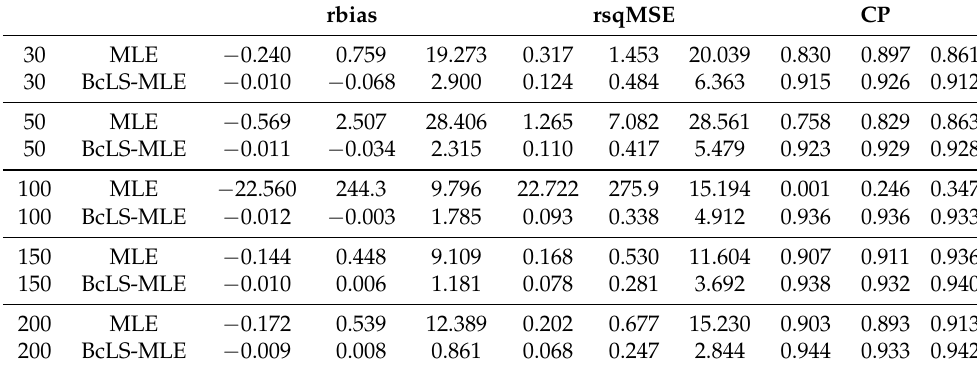
Table 7. The rbias and rsqMSEs of the BcLS-MLE and MLE, and the CP of S ( y 0 | Θ ) for LPN ( Θ )